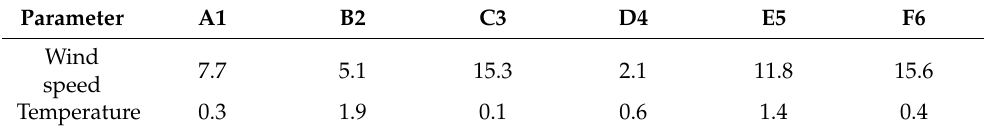
Table 5. Measured and simulated MAPE values (%) in summer in Zhuqiao